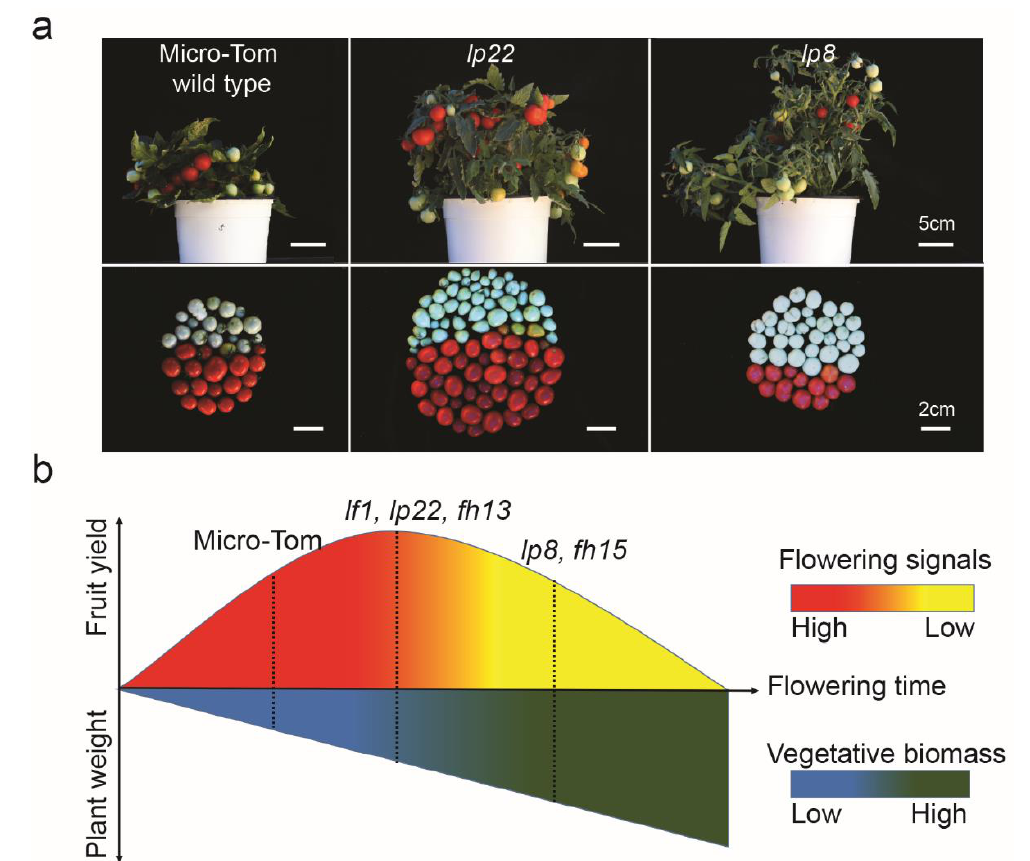
Figure 6. Representative tomato yields and yield dynamic model with flowering time variants. ( a ) Representative vegetative biomass (top images) and tomato yield (bottom images) with three different flowering time variants. Notably, lp22 shows a balanced growth with optimal late-flowering, maximum yields, and optimal-increment of biomass (middle images). lp8 was grown with extremely late-flowering, lower yield, and higher amount of biomass (right images). Upper size bar, 5 cm; bottom size bar, 2 cm. ( b ) Yield dynamics model with plant performance under varying flowering time (Figure S3, Table S4). This model suggests the optimal flowering time variants such as lf1 , lp22, and fh13 get the optimal vegetative mass and fruit sets (dashed lines) bearing well-balanced vegetative and reproductive organ production for a higher yield. This model also suggests that an extremely late-flowering time, such as that of lp8 and fh15 plants, produces excessive vegetative mass but achieves less fruit yields.